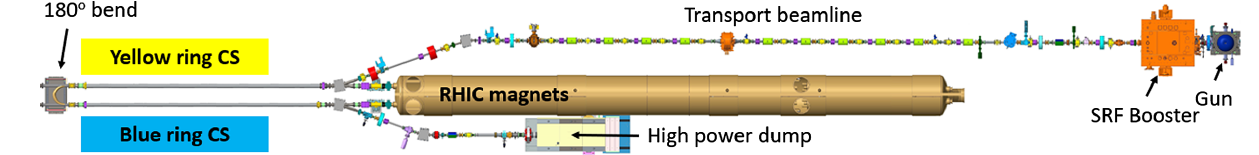
FIG. 1. Schematics of LEReC layout (not to scale).